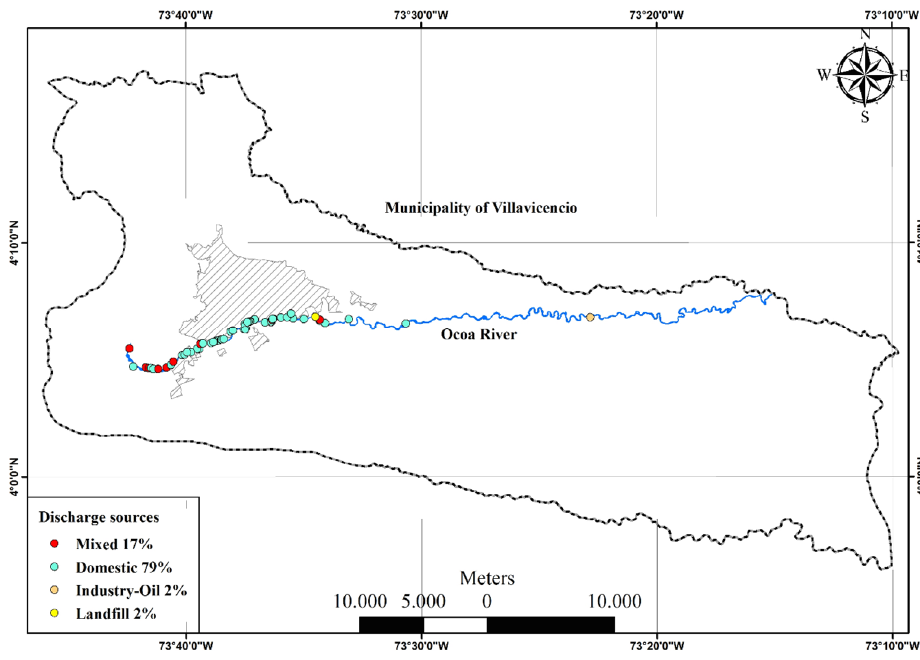
Figure 2. Distribution and sources of discharges in the Ocoa River. The stripped pattern shows urban